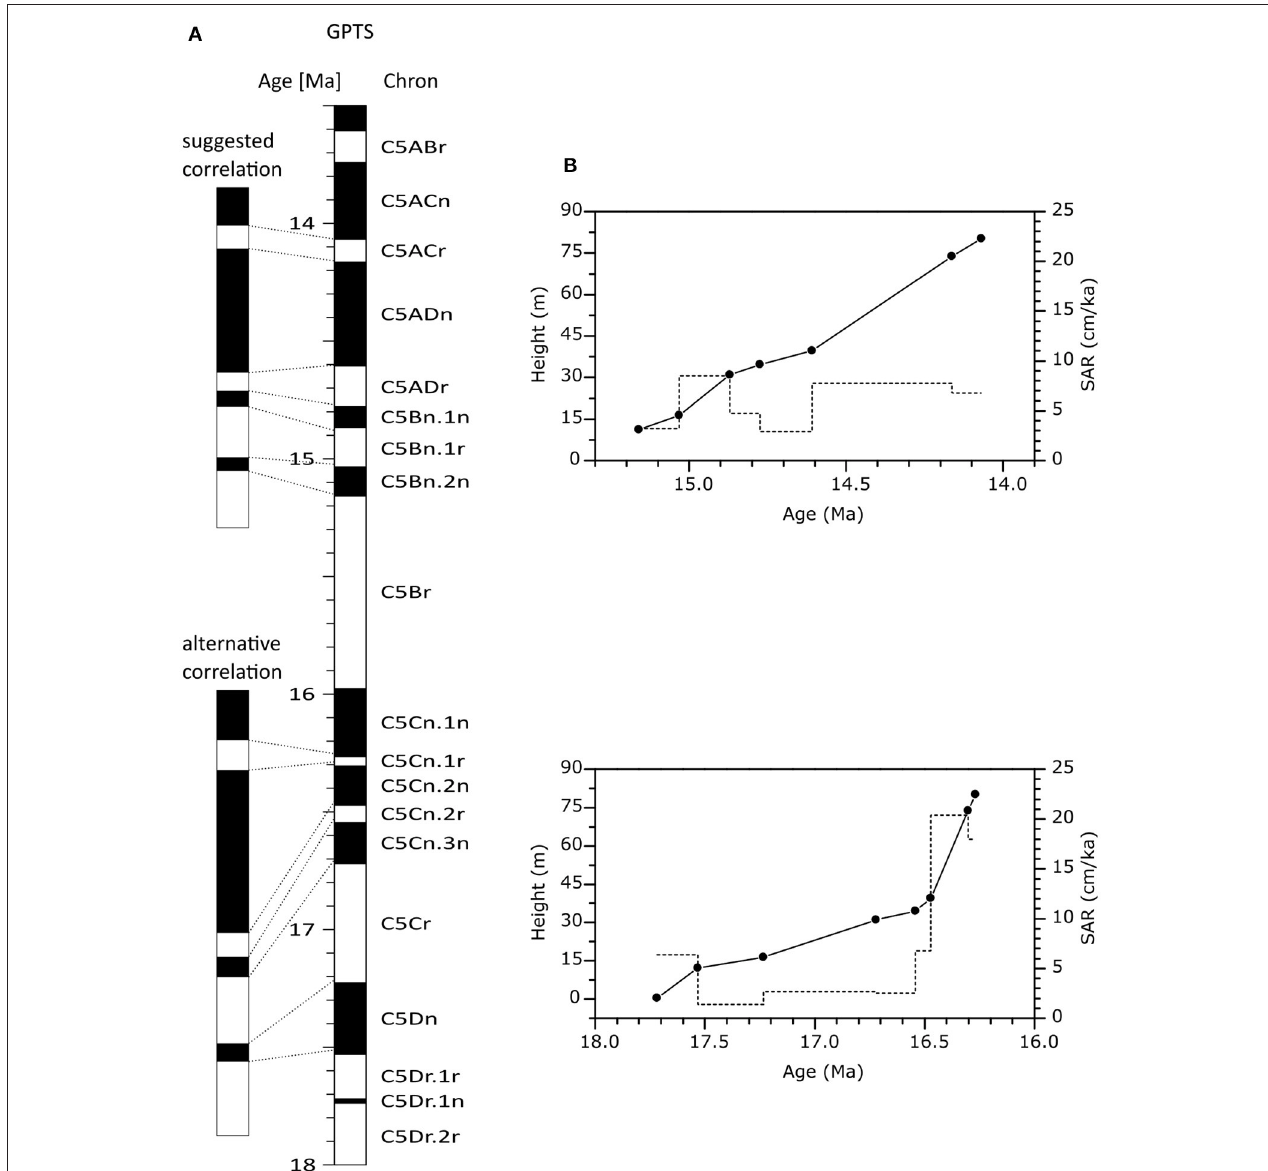
FIGURE 14 | (A) Suggested and possible alternative magnetostratigraphic correlation of the polarity pattern retrieved from the VGP latitude to the GPTS after Gradstein et al. (2012), (B) corresponding height vs. age plots (black line) with sediment accumulation rates (SAR, dashed line) calculated for each fully resolved